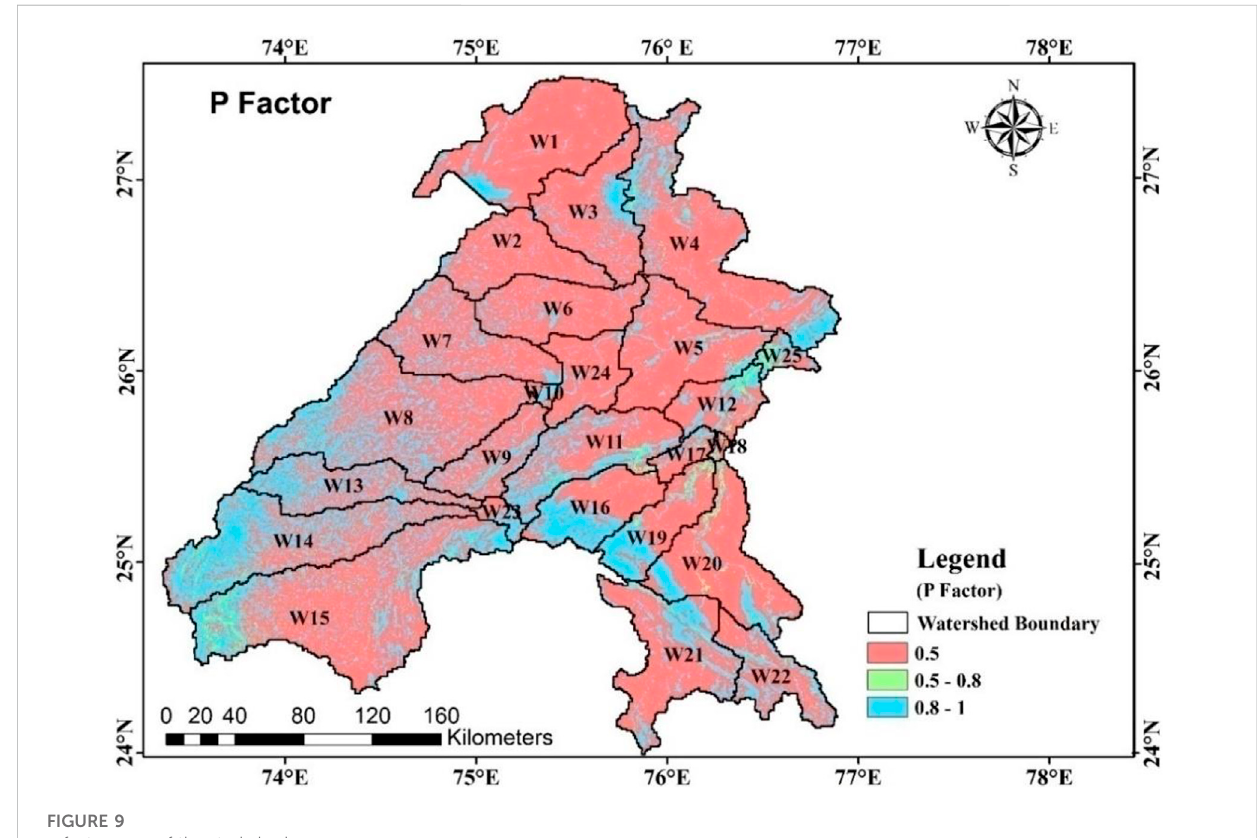
FIGURE 9 p factor map of the study